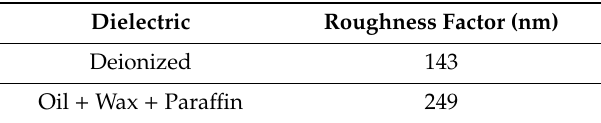
Table 13. Topographical analysis of the wire electrical discharge machined Al-SiC-TiC metal matrix composite.